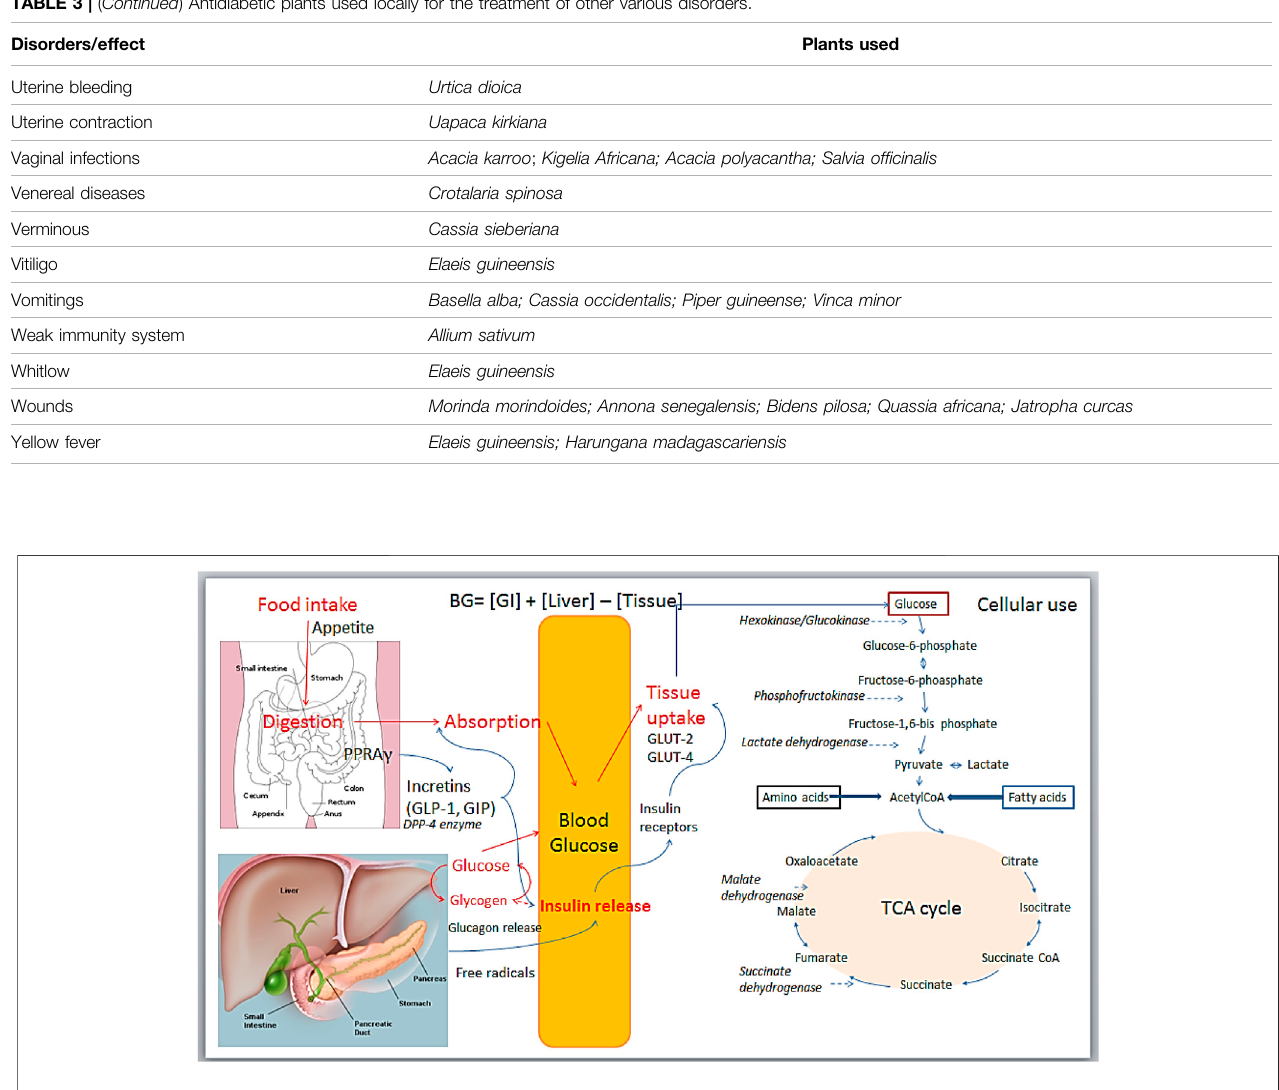
FIGURE 6 | Illustrative sites and pathways of antidiabetic bioactivity.